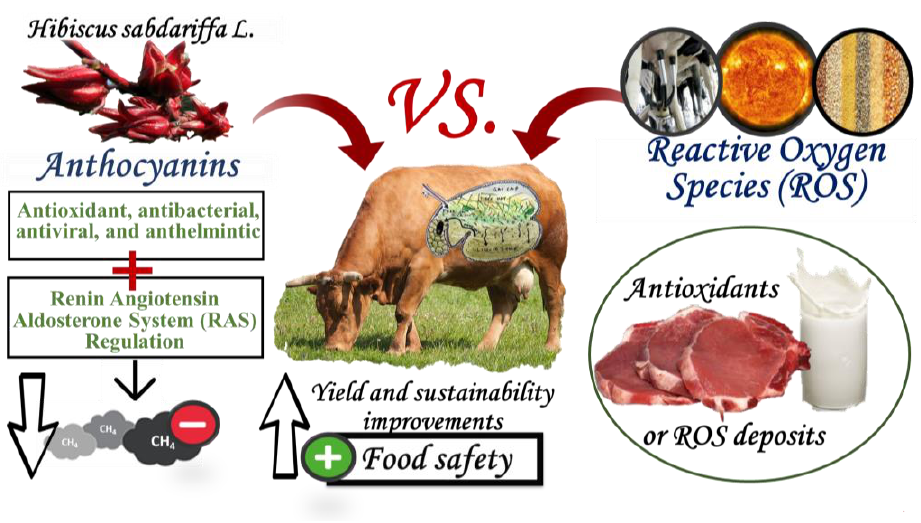
Figure 1. Overall economic, environmental, and productive effects of including Hibsicus sabdariffa L. calyxes and by-products in ruminant diets.